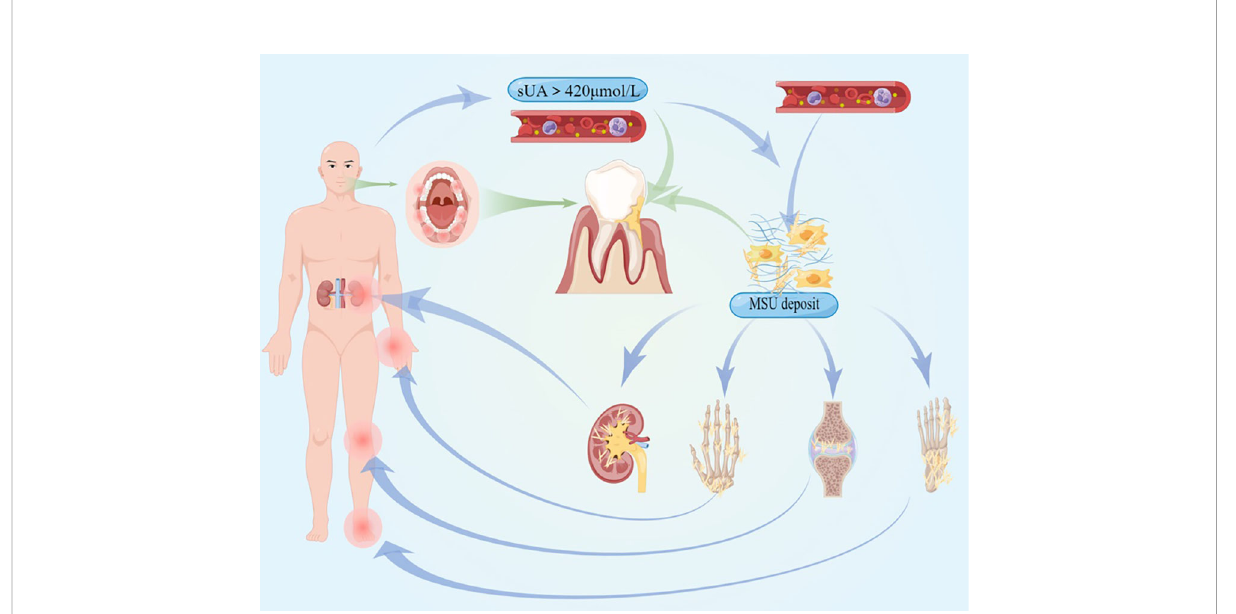
FIGURE 1 The pathogenesis and clinical symptoms of hyperuricemia and gout are illustrated, and the systemic in fl ammation they cause could affect the procession of